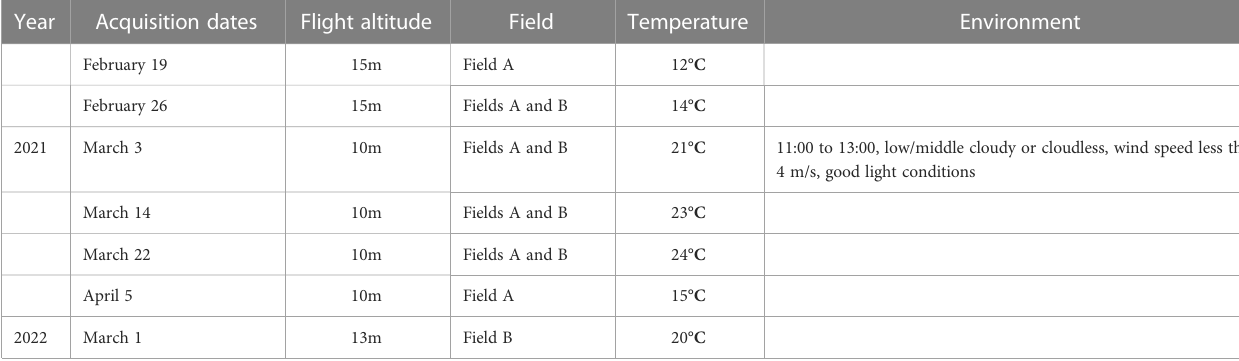
TABLE 1 Image acquisition at Wuhan, Hubei Province, China, in 2021 and 2022.